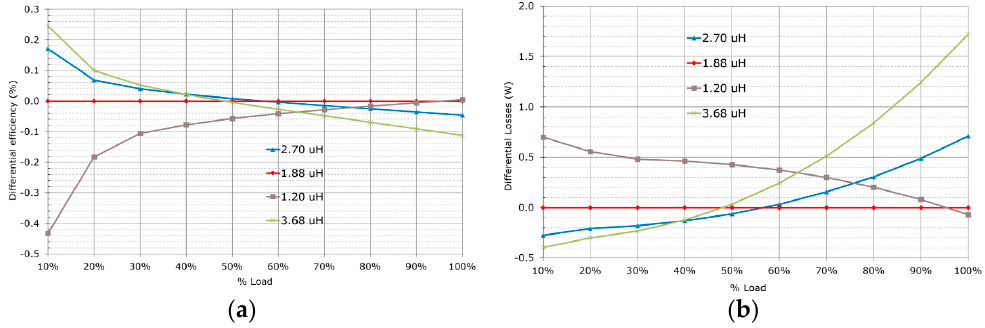
Figure 13. Performance comparison for different numbers of turns of the output inductor: ( a ) differential efficiency; ( b ) differential losses.